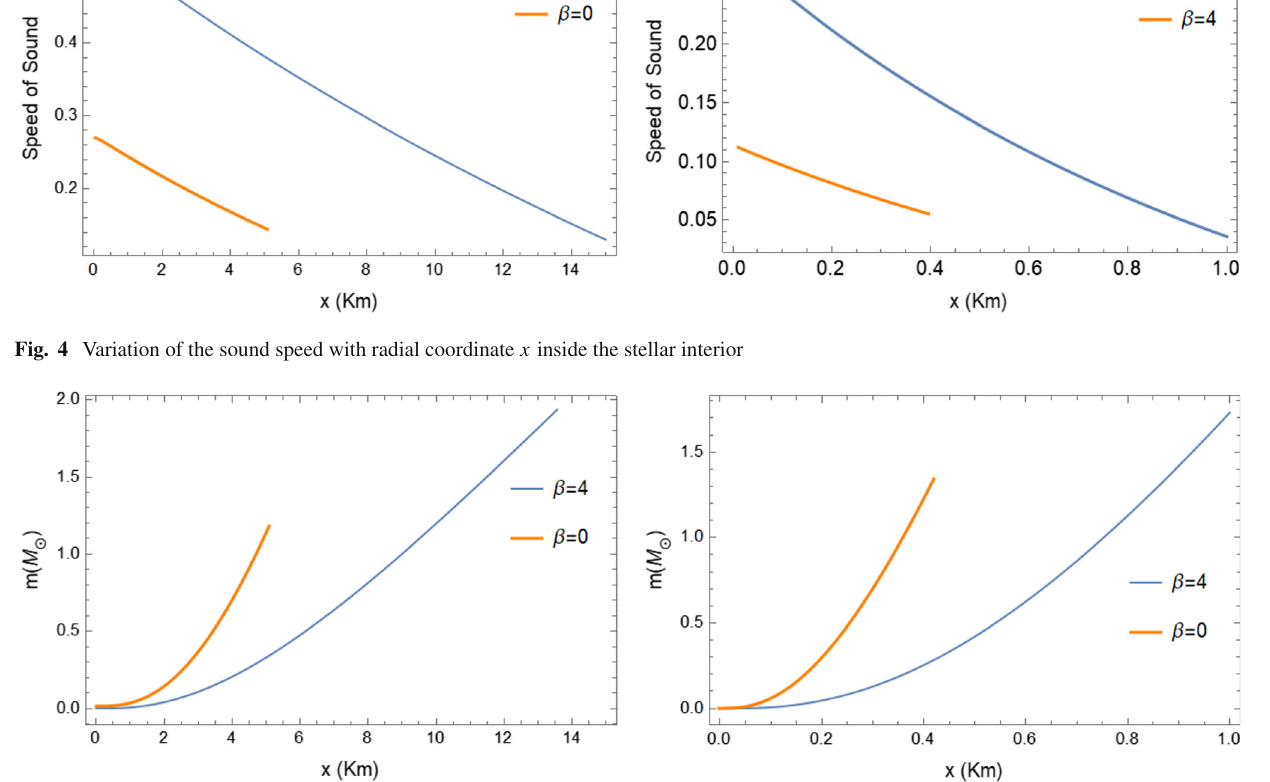
Fig. 5 Variation of mass–radius